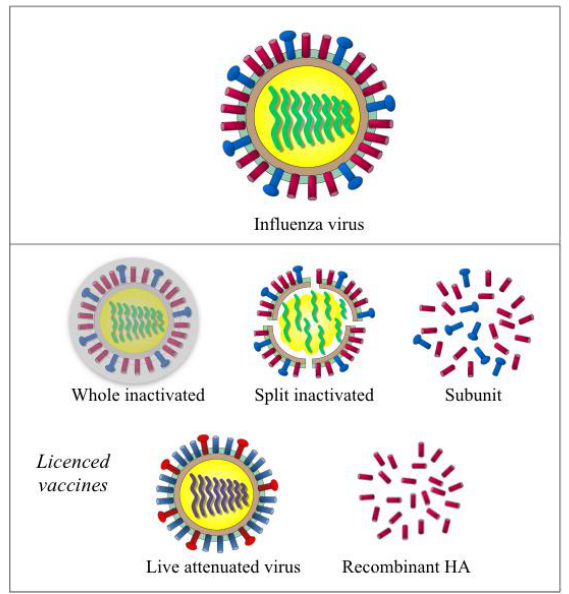
Figure 1. Illustration of the influenza virus and currently licensed vaccines. Influenza virus (the top panel) is a RNA virus with eight segments of negative sense single strand RNA genome. Two major surface glycoproteins hemagglutinin (HA, in red) and neuraminidase (NA, in blue) are the main antigenic components in inactivated influenza vaccines (the middle panel including whole inactivated, split inactivated and subunit vaccine). Live attenuated vaccine (left in lower panel) uses HA and NA that were expressed with the backbone of cold-adapted, temperature-sensitive attenuated master donor virus to elicit a multifaceted immune response. Recombinant-HA vaccine (right, lower panel) is produced in insect cells using a baculovirus vector.